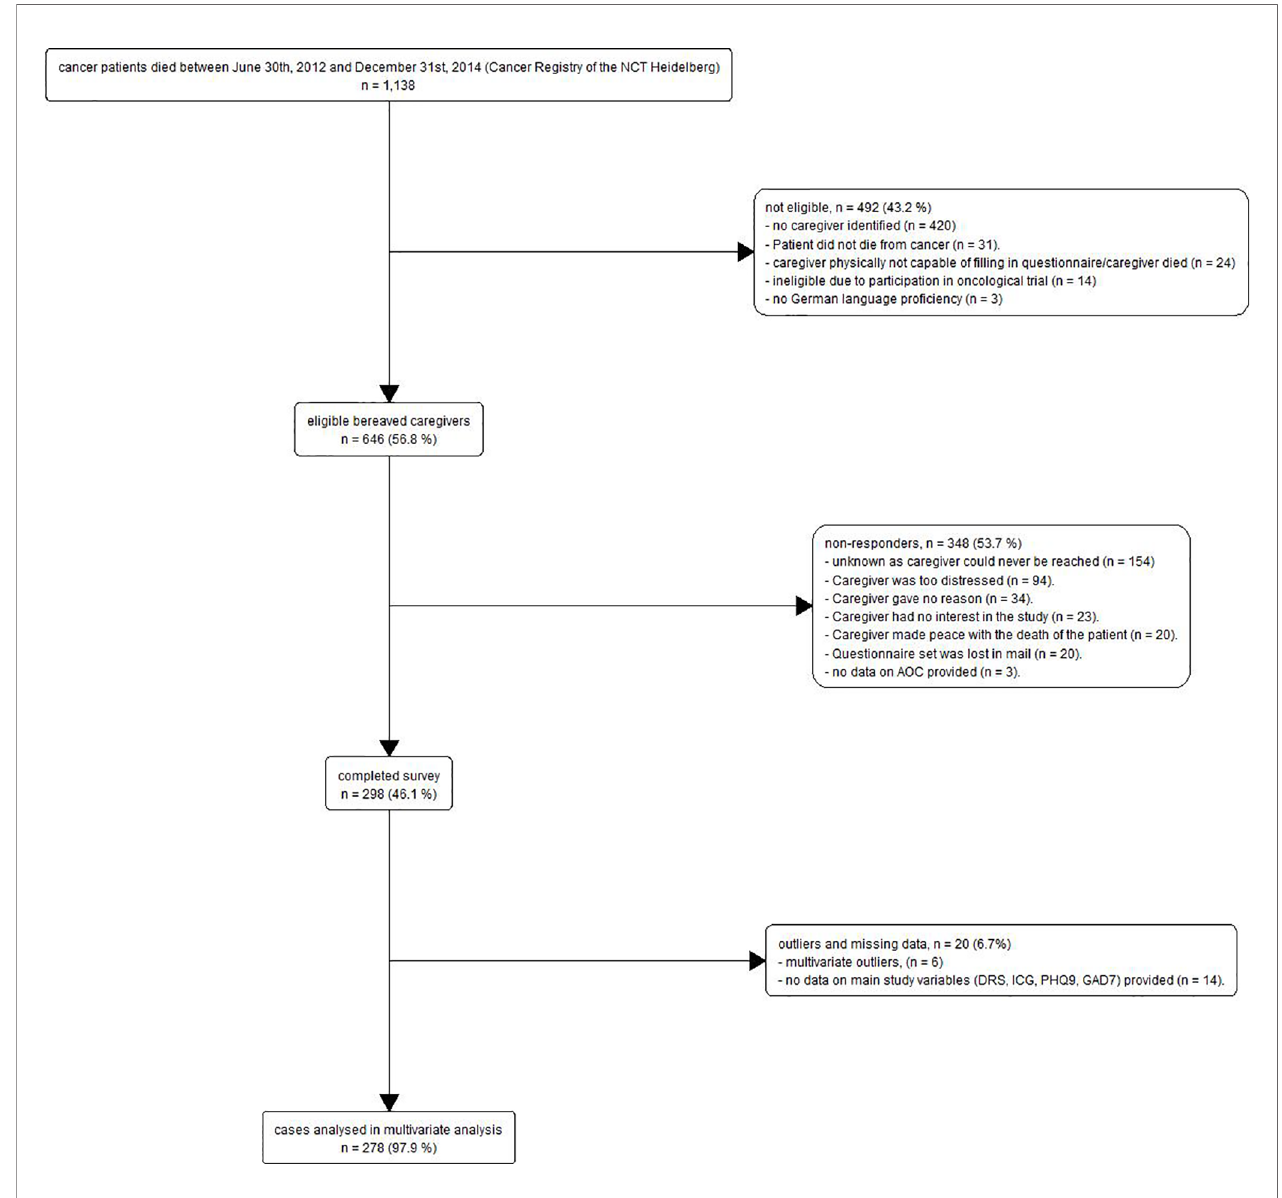
FIGURE 1 | Study Flow